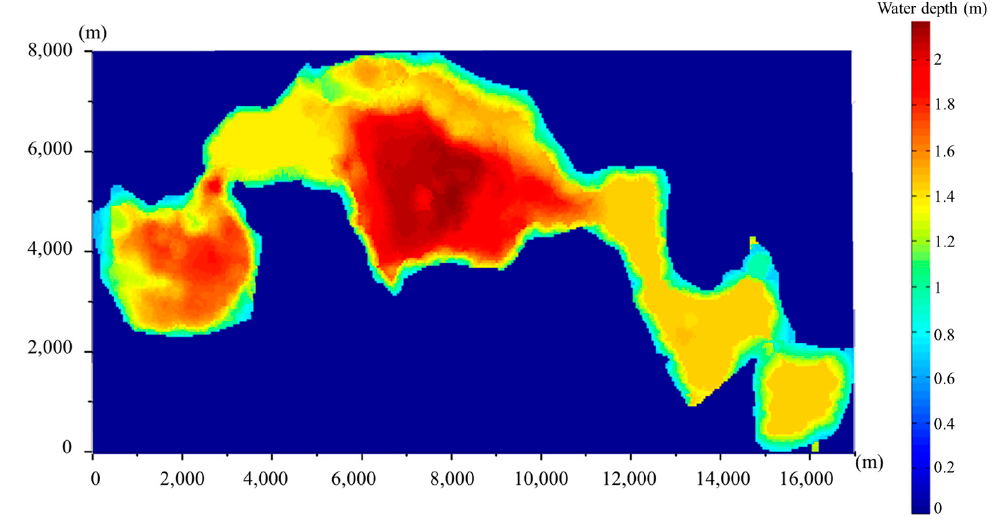
Figure 6. Initial water depth in Baihe Lake.